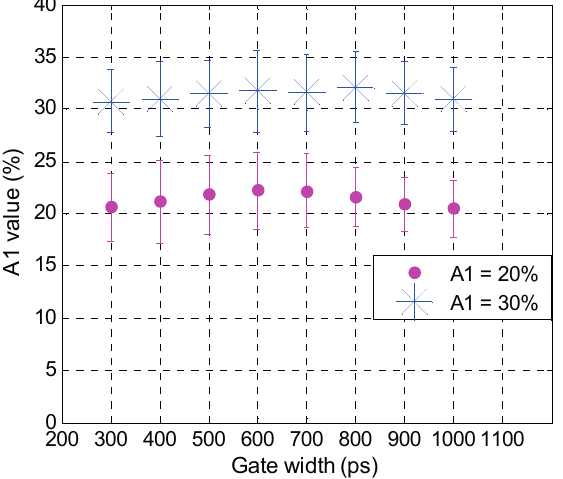
Figure 3. Trends in ( a ) absolute error and ( b ) standard deviation for estimation of A 1 under low-light conditions (maximum of the TPSF at 1000 photons) and 300 ps, 600 ps, 1000 ps gates.